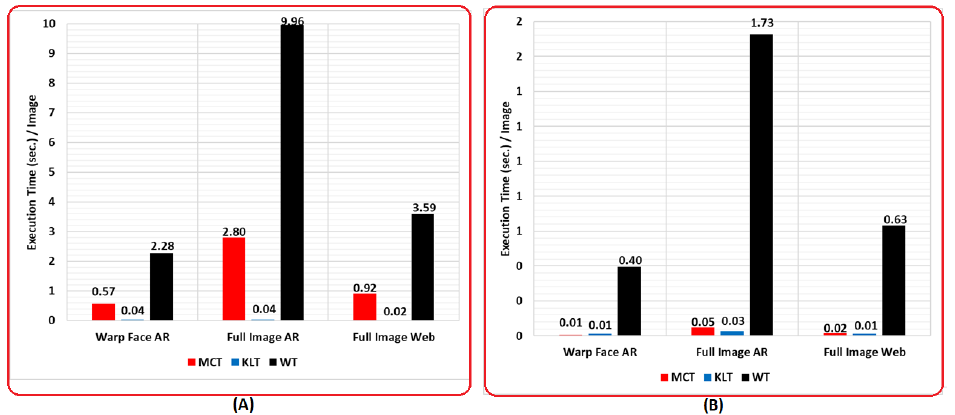
Figure 18. The execution time of ( A ) Coding operation and ( B ) Decoding operation for the proposed MCT, and the other existed method KLT and WT across all used